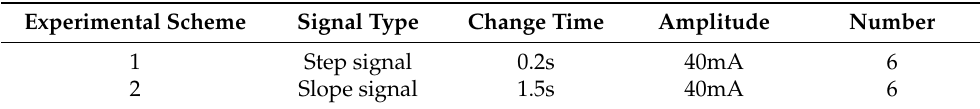
Table 2. Experimental scheme table.